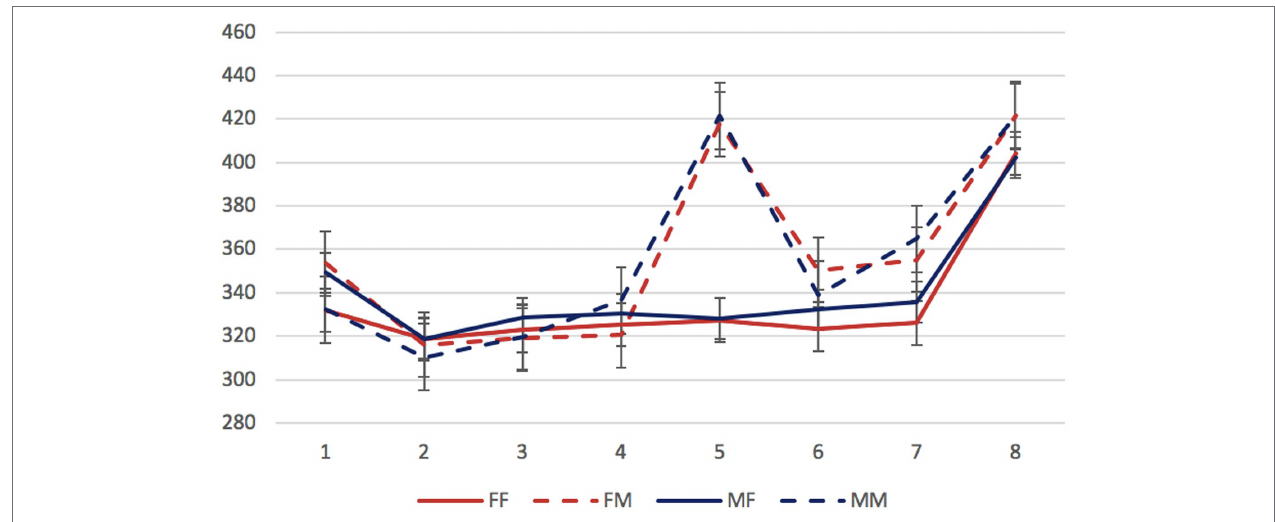
FIGURE 3 | Experiment 1, the non-syncretic animate dependent group: mean RTs per region (in ms) in the four experimental conditions. Regions: N 1 (head)— preposition—N 2 (dependent)—copula ( byt’ “to be”)—adjective/participle—three words modifying the predicate. Error bars represent the standard error of the condition mean.